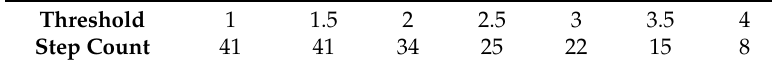
Table 3. Step measurements in different thresholds.